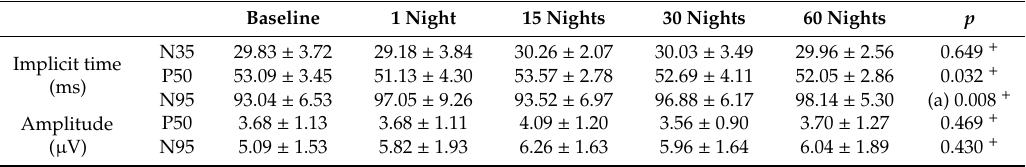
Table 2. Description (Mean ± SD) of the variation of the components of the PERG wave [implicit time of N35, P50 and N95 (expressed in ms) and the amplitude of P50 and N95 (expressed in µ V)].